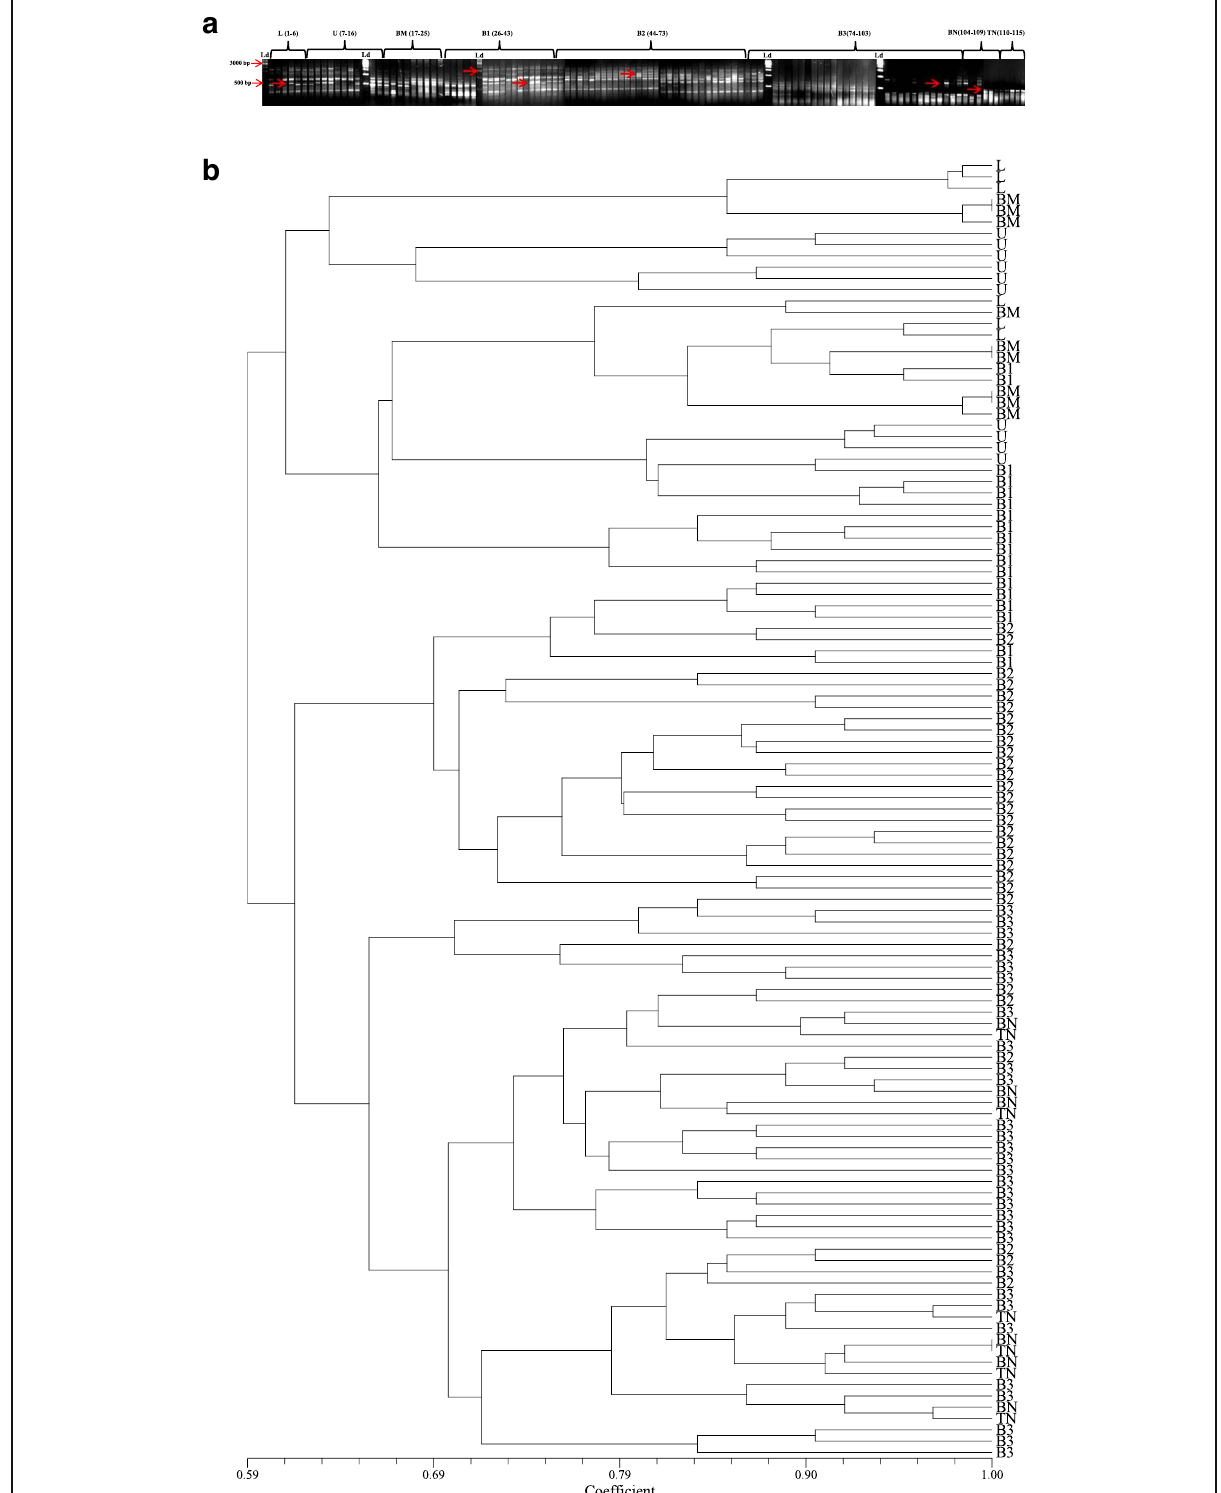
Fig. 4 ISSR profiles; a banding profile in I . griffithii populations using primer SUNSRK-14, b genetic distance recorded with ISSR primers